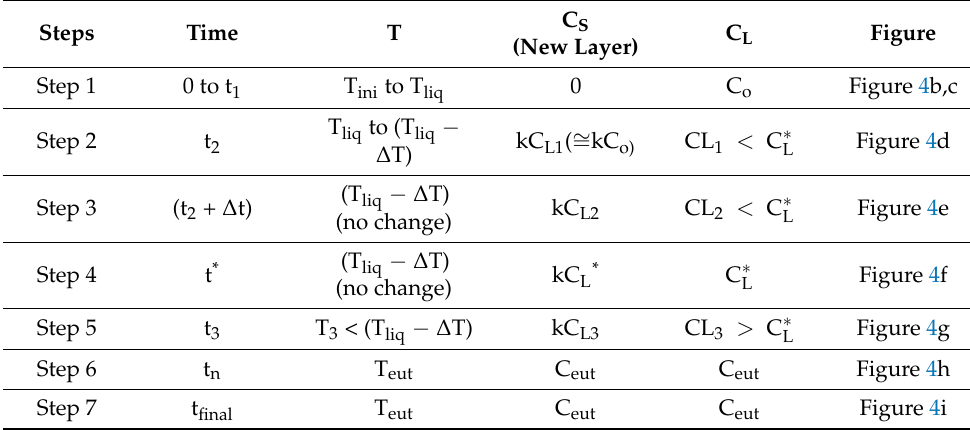
Table 2. The various steps in the solidification of a CV of a binary